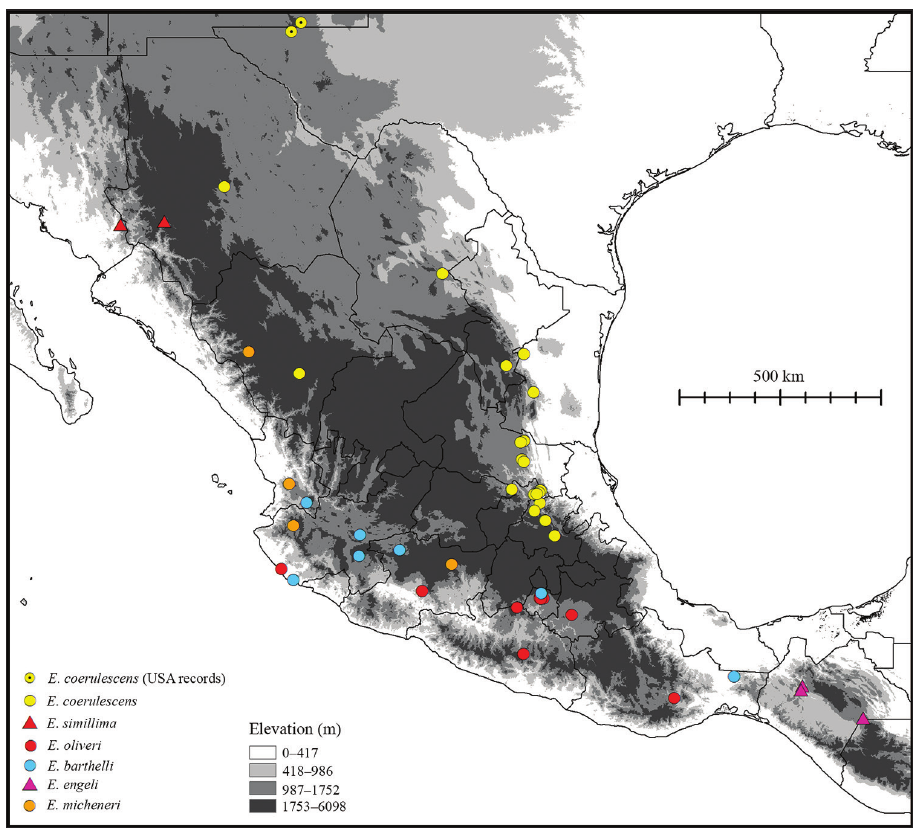
Figure 128. Collection localities for species of Eufriesea of the coerulescens group.